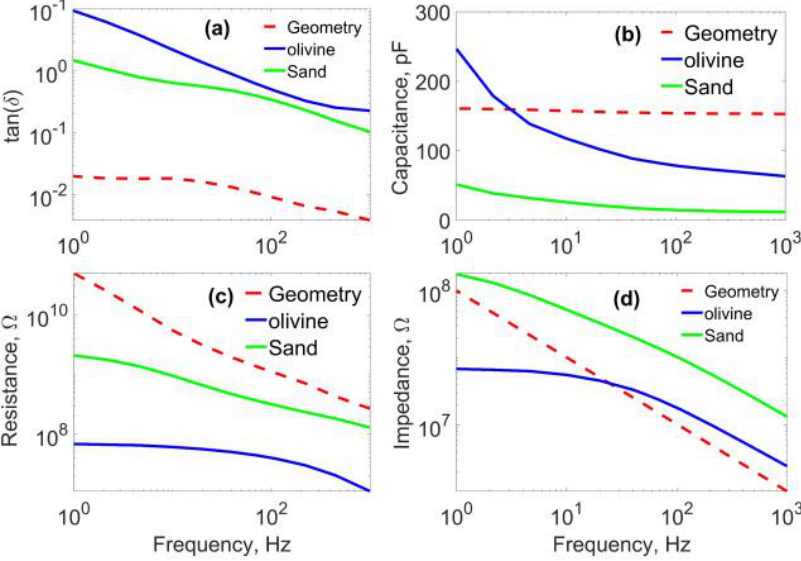
Figure 6. Volume parametric electrical properties of the DBD bed materials measured at ambient temperature. ( a ) Loss factor; ( b ) capacitance; ( c ) resistance; ( d ) impedance. Table 2. Volume electrical properties of the DBD bed materials measured at frequencies from 1 Hz to 10 3 Hz.